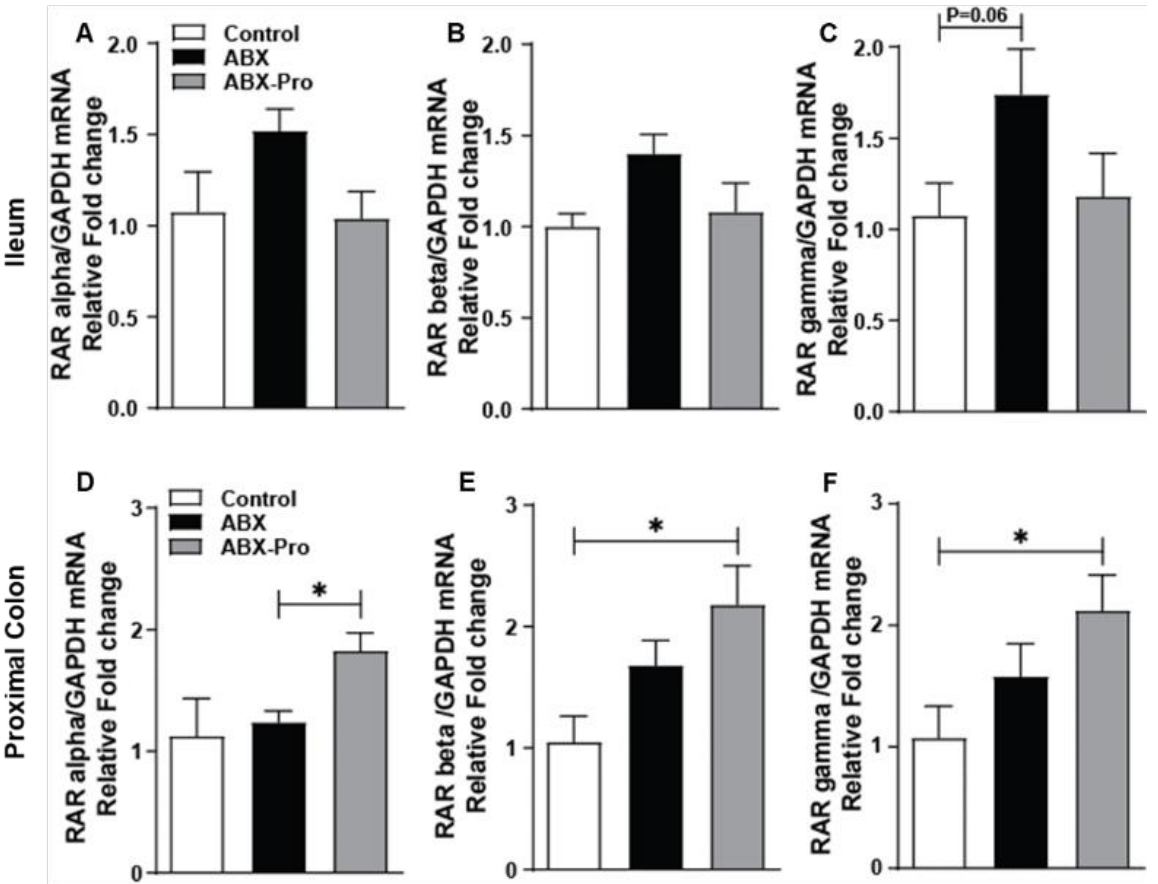
Figure 6. Retinoic Acid Receptors. Mice were treated as described in Figure 1. At euthanasia, ileum and proximal colon were dissected and relative mRNA expression of RAR-alpha, RAR-beta and RAR-gamma in the ( A – C ) Ileum and the ( D – F ) Proximal Colon was detected using qRT-PCR. Values represent mean ± standard error of the mean. * p < 0.05.